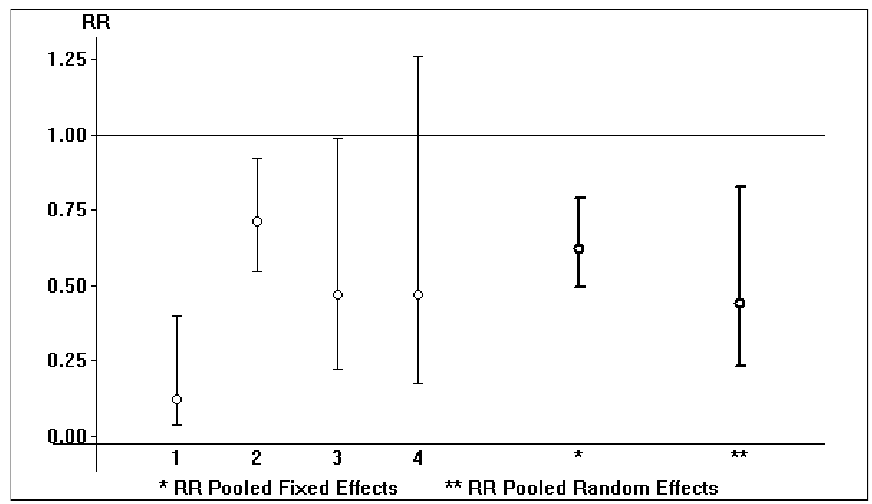
Figure 1. The impact of antiviral therapy on death rate in patients with advanced CKD: pooled adjusted RR according to fixed- and random-effects models.